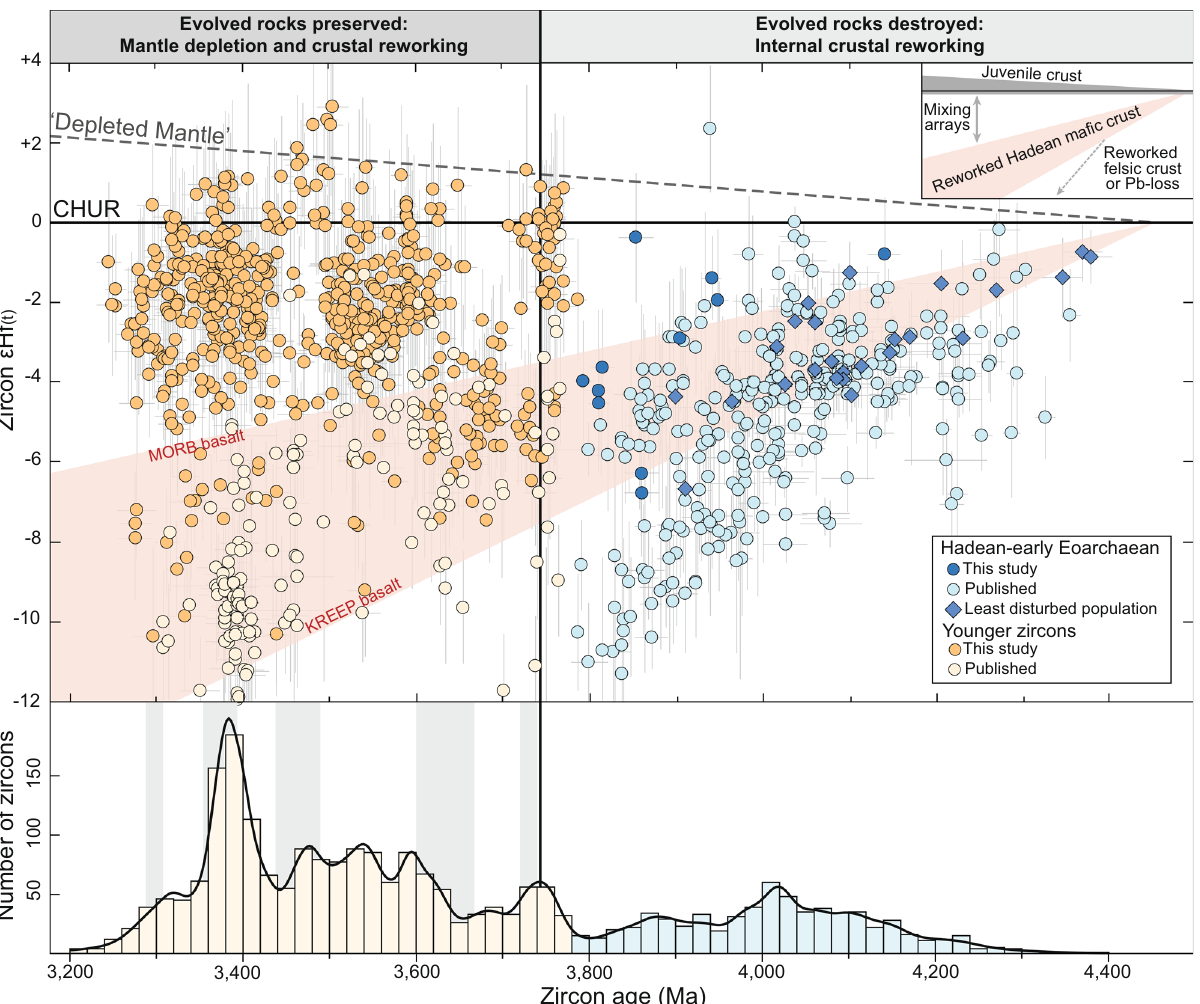
Fig. 2 Plot of initial epsilon hafnium ( ε Hf (t) ) versus zircon age for Hadean and Archaean detrital zircons from the Yilgarn Craton. Most pre-3800Ma detrital zircons de fi ne a Hf isotopic array consistent with internal reworking of early Hadean ma fi c sources such as typical mid ocean ridge basalt ( 176 Hf/ 177 Hf = 0.026) or Hadean incompatible element enriched lunar basalt (KREEP, 176 Lu/ 177 Hf = 0.020; ref. 14 .). From ~3750 Ma onwards, detrital zircon age populations de fi ne vertical ε Hf (t) – time groups that re fl ect mixing between juvenile sources and pre-existing Hadean crust. The grey dashed line de fi ning the depleted mantle is approximately fi tted through the most juvenile zircon analyses. Error bars are 2SE. CHUR chondritic uniform reservoir. Only published data collected by concurrent Pb – Hf analysis are shown 3,14 . A kernel density estimate curve and histogram of zircon ages (new and previously published) are shown at the bottom of the diagram. The grey bars behind the histogram correspond to the age of crust preserved in the Narryer Terrane 18